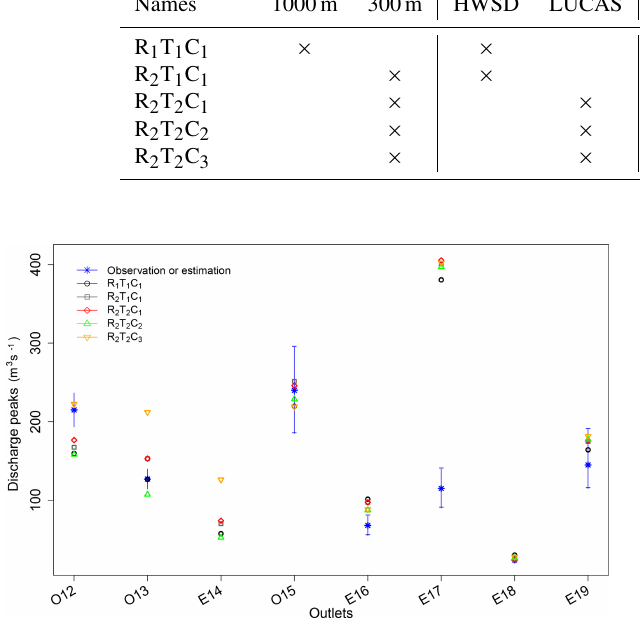
Figure 7. Discharge peaks (m 3 s − 1 ) observed or estimated in blue and simulated by the R 1 T 1 C 1 –R 2 T 2 C 3 experiments for each catch- ment for the October 2015 event. The error margins (blue segments) in the observed values (O no.) are approximately 10%, and the er- ror margins for the others (E no.) were estimated using post-event surveys. Only the damage was registered for E14 during this event; therefore, no estimate is available. For E18, the discharge values ranged between 20 and 28m 3 s − 1